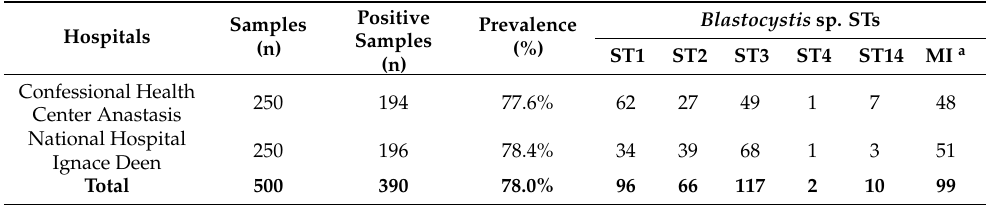
Table 2. Prevalence and ST distribution of Blastocystis sp. in the two Guinean hospitals screened in the present